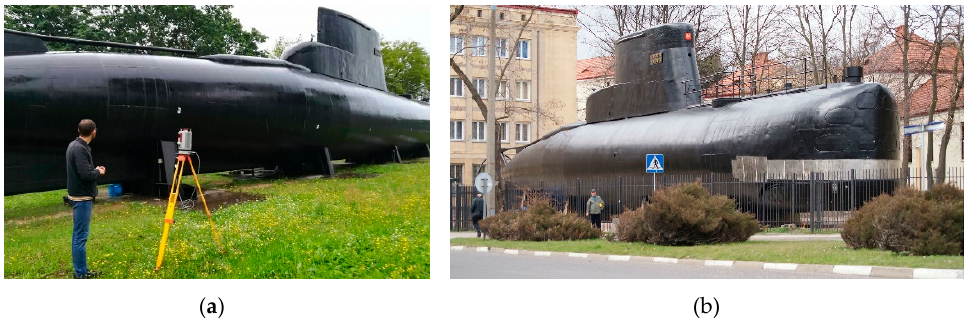
Figure 1. PNS Jastrzab—decommissioned submarine—object of research: ( a ) wet object during laser scanning with control points, ( b ) general view of the submarine (source: by Pawel Kusiak, CC BY-SA 4.0, https://commons.wikimedia.org/w/index.php?curid=42676502).